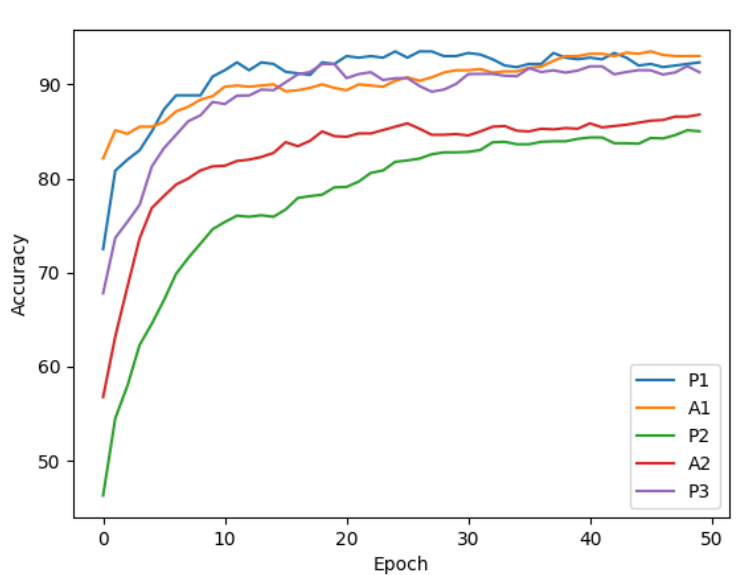
Figure A1. Accuracy over time.